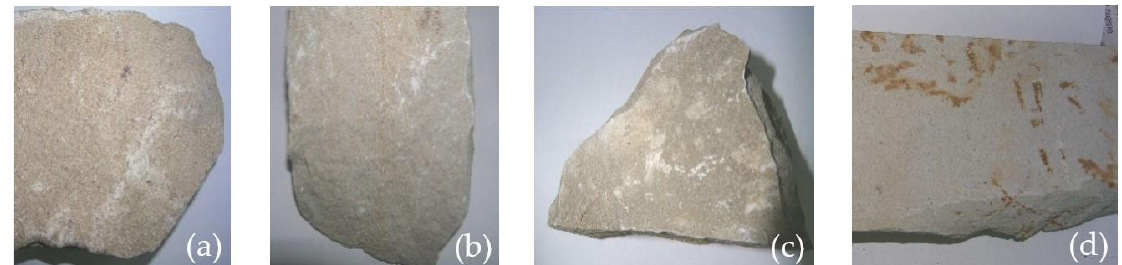
Figure 3. ( a ) S1: sample series dislodged from the original 19th century wall of The Church of The Holy Archangels Michael and Gabriel; ( b ) S2: sample series extracted from Egoreni stone quarry; ( c ) S3: sample series extracted from Poiana Deleni stone quarry; ( d ) S4: sample series extracted from Vama stone quarry.